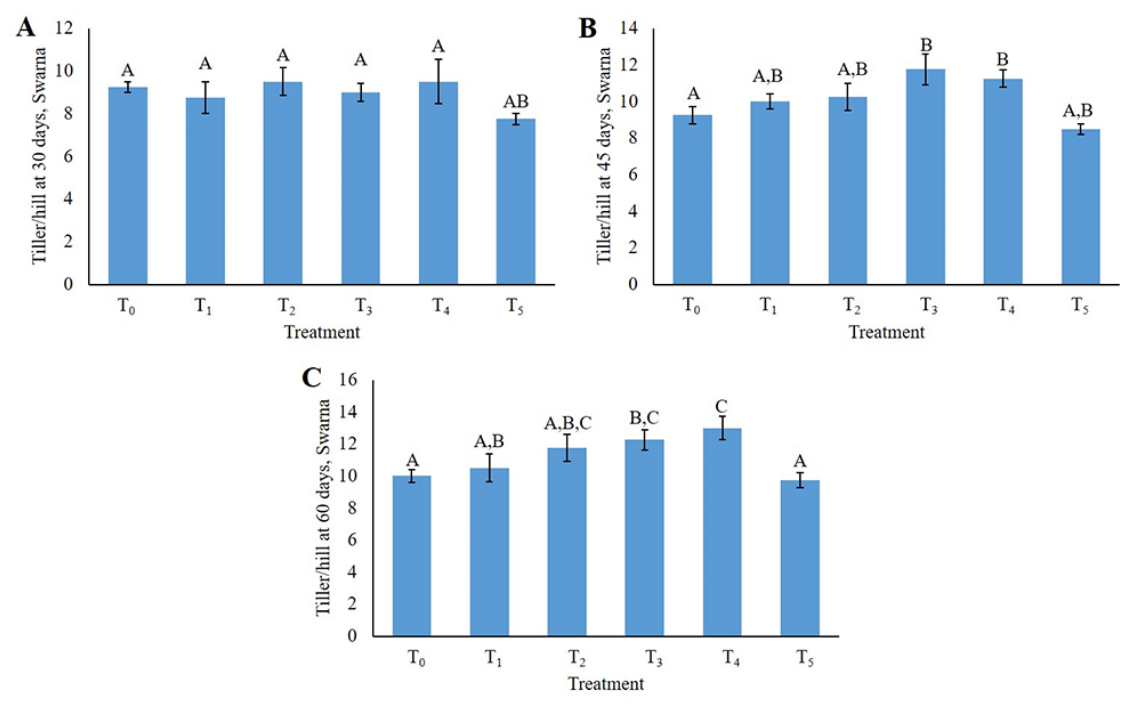
Figure 2 Influence of boron in saline conditions on the number of tillers per hill for the rice ‘Swarna.’ ( A ) 30 DAT; ( B ) 45 DAT; and ( C ) 60 DAT. T0: Saline condition, EC = 9.0 dS/m + no additional boron; T1: No saline condition + no additional boron; T2: Saline condition of EC 9.0 dS/m + boron application as solubor at a rate of 4.5 kg B ha − 1 ; T3: Saline condition of EC 9.0 dS/m + boron application as solubor at a rate of 5.9 kg B ha − 1 ; T4: Saline condition of EC 9.0 dS/m + boron application as solubor at a rate of 7.5 kg B ha − 1 ; T5: Saline condition of EC 9.0 dS/m + boron application as solubor at a rate of 10 kg B ha − 1 . Data are the means of four replicates ± SEM . All data were analyzed by one-way analysis of variance. Tukey’s test was used to identify the differences between treatments. Values with different superscript characters (A, B, C) are significantly different ( p <